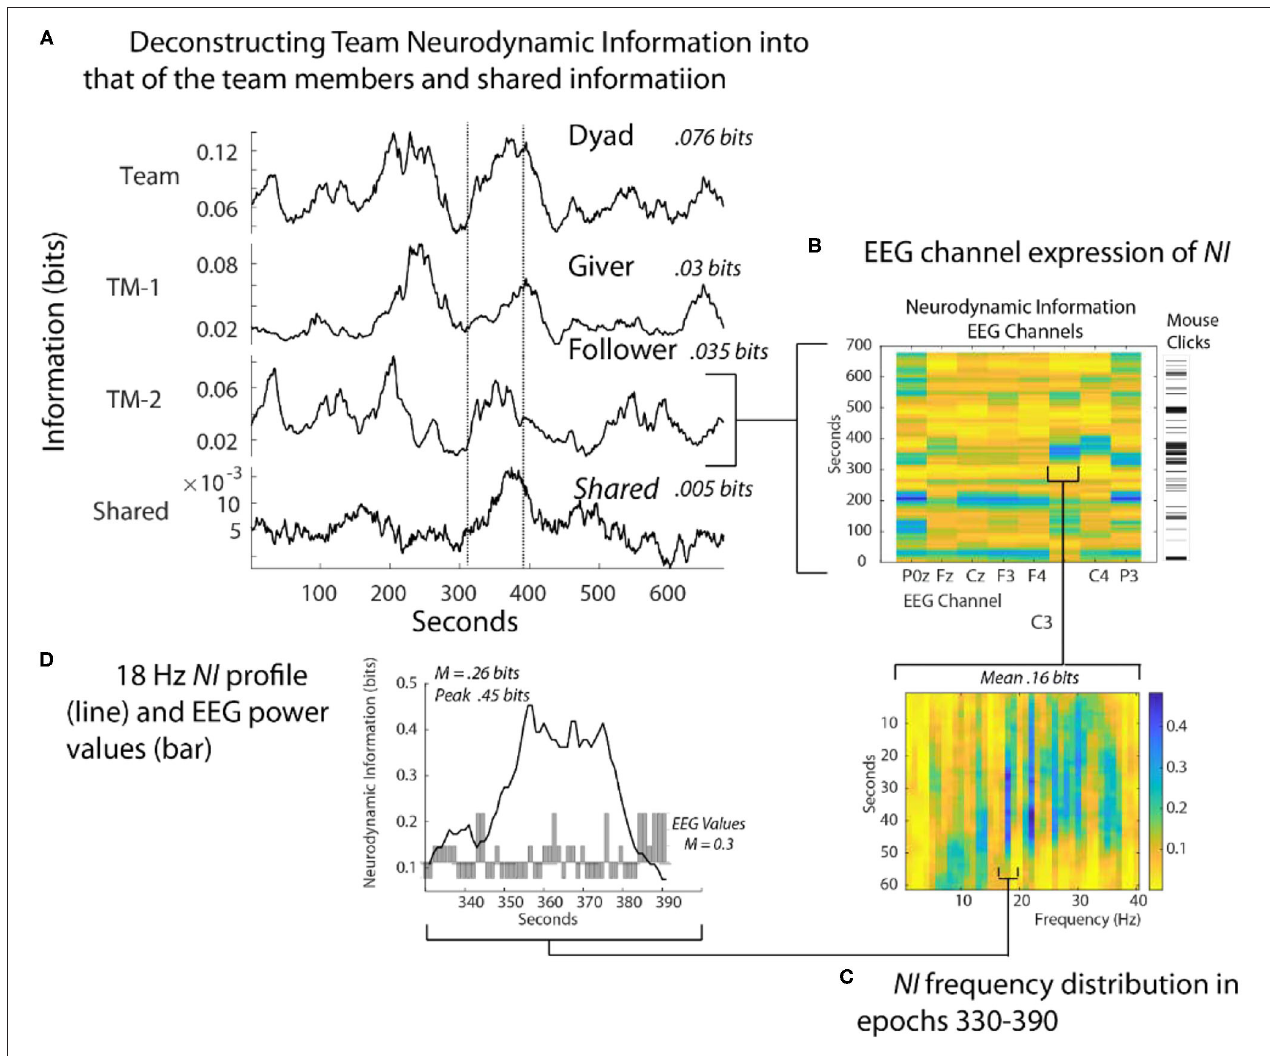
FIGURE 4 | Quantitative comparisons of NI across spatial scales. (A) The bits of information of the team, team members, and their shared information is shown for a Map Task performance; the two lines are there for aligning the panels. (B) The NI dynamics at each sensor of the Follower. The bar to the right shows the density of his mouse clicks which increased around 330s when he verbalized uncertainty. (C) The elevated NI at the C3 sensor is expanded for one segment (epoch 330-390s) and displayed across the 1–40Hz EEG frequency spectrum. (D) A profile plot of NI in the 18Hz frequency band is overlaid with a bar plot of the − 1, 1, and 3 EEG-PV . All NI values are shown after the subtraction of NI from parallel randomized NDS